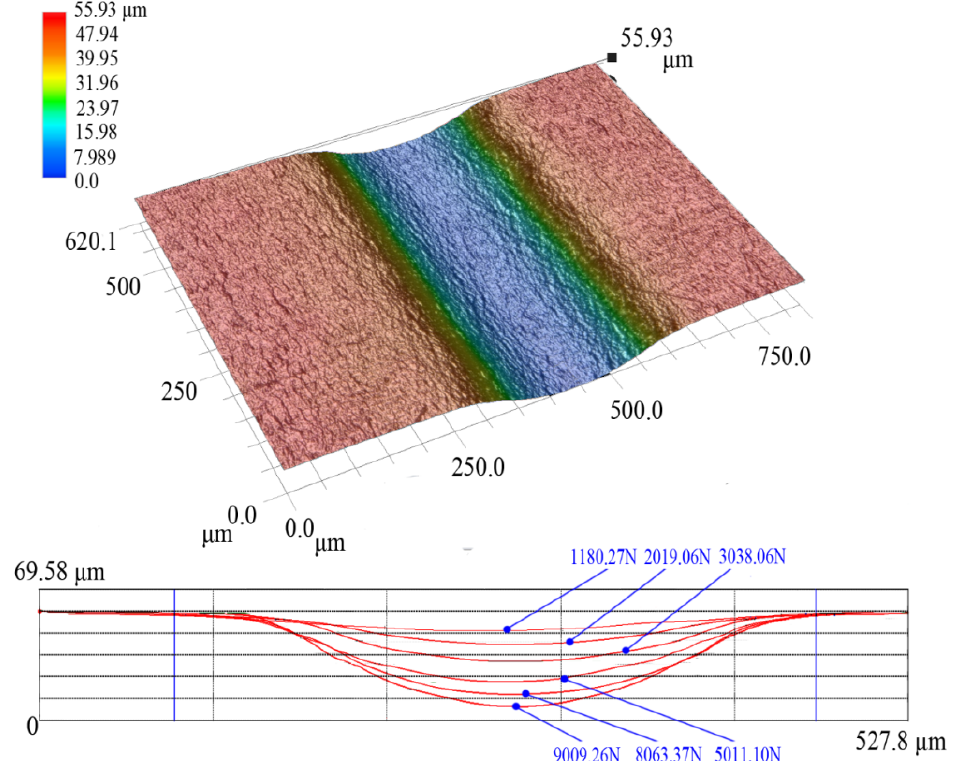
Figure 7. One magni fi cation micro-topography of the micro-channel located in the middle region of the metal sheet and six profile curves of channels with different final load